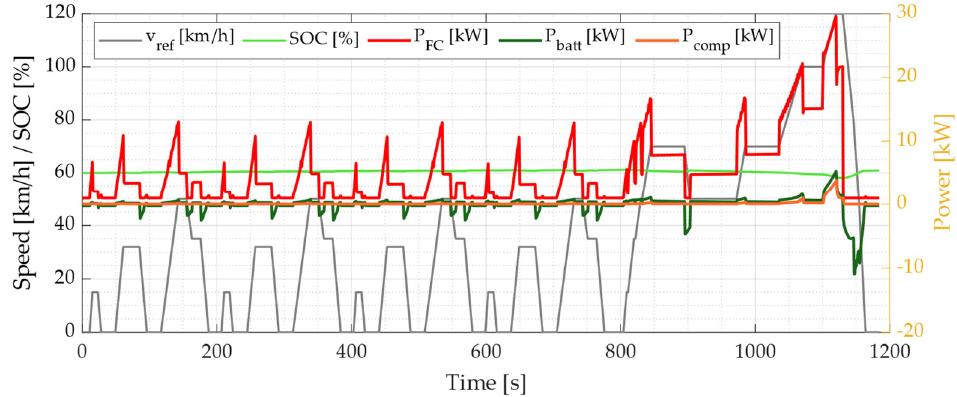
Figure 11. Simulation conducted on NEDC driving cycle with fuzzy logic control strategy.